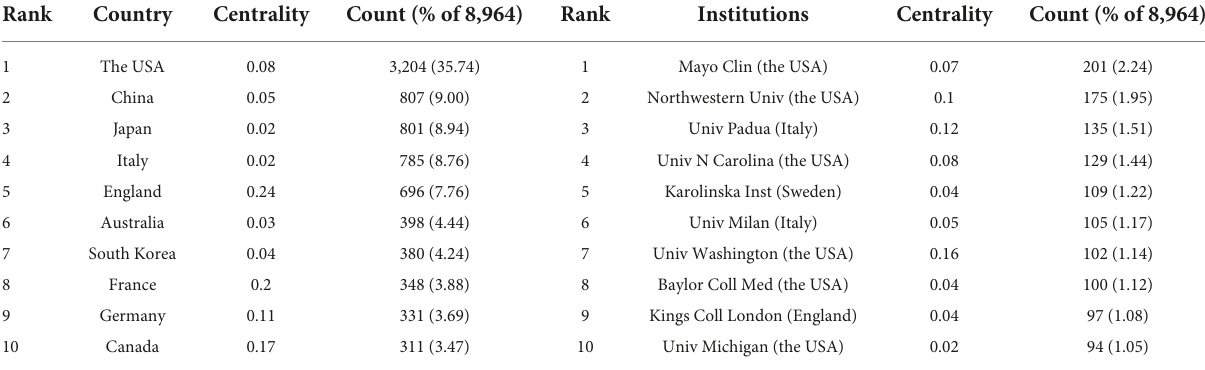
TABLE 1 The top 10 countries or regions and institutions involved in GERD